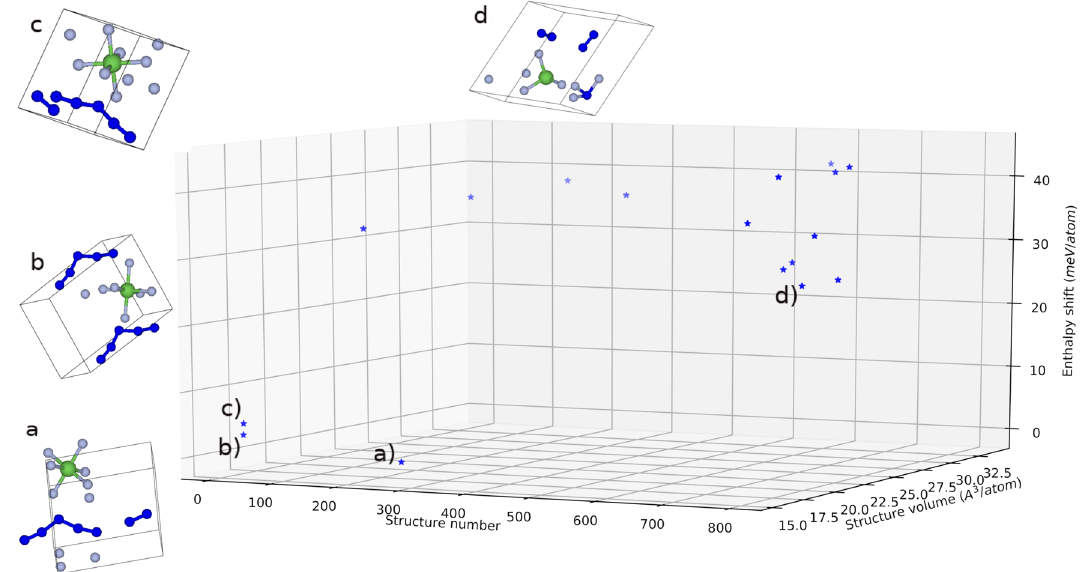
Figure 1. 3-D plot depicting the overall evolutionary search performed with the USPEX 23–25 code and quantum espresso DFT 26,27 engine for geometry optimization. 28 Generations with a total of 790 crystal structures were produced for optimization. For clarity only the best 16 structures were plotted against their structure number along the search, their corresponding volume and enthalpy. Ball and stick representation of the best four structures ( a – d ) are presented along with their position in the enthalpy/volume V-H landscape. The enthalpy shift is from the best structure (structure ( a )) in meV/atom).